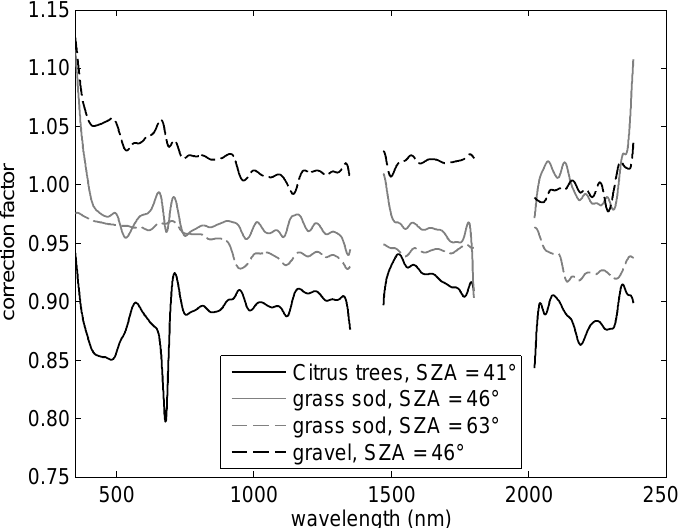
Figure 8. Normalization factors derived for four field measurements